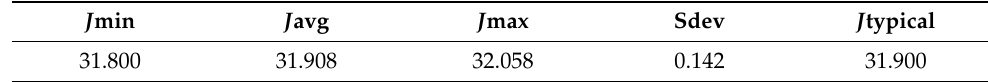
Table 2. Statistic regarding the optimum